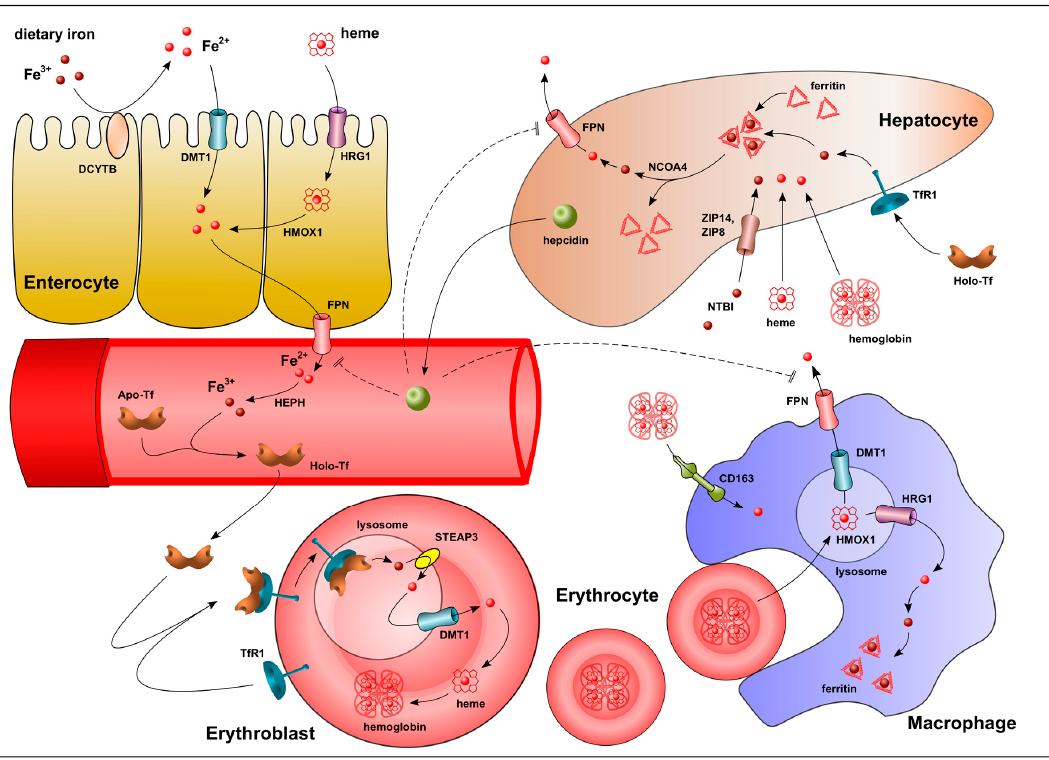
Figure 1. Schematic representation of the factors involved in systemic iron absorption, utilization, storage, and recycling.